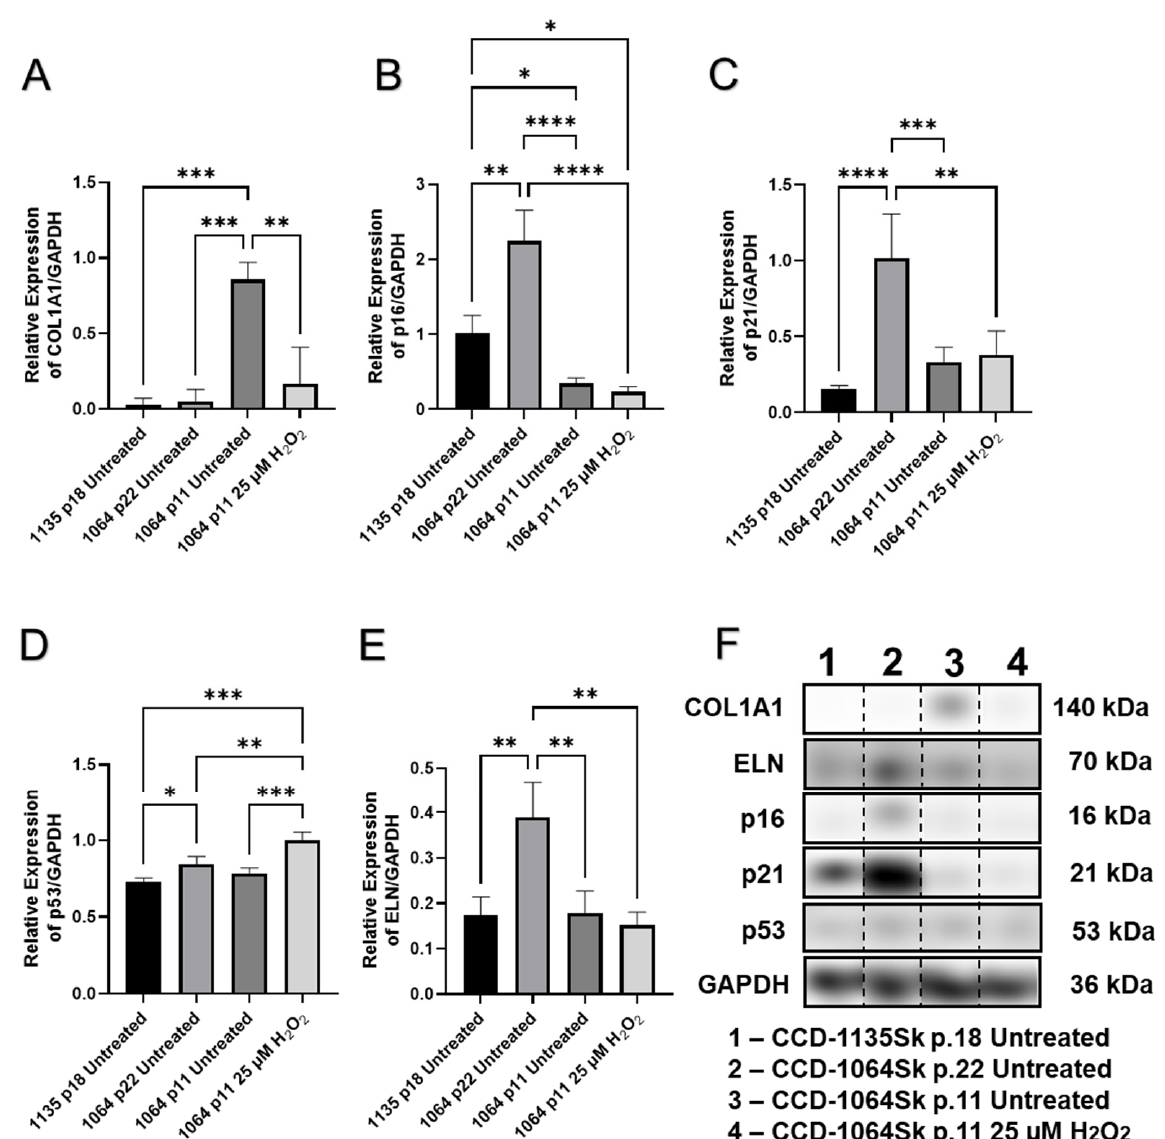
Figure 6. The expression of cellular checkpoint regulators and collagen in aged fibroblasts from different cell lines. Fibroblast’s cell-lines CCD-1135Sk (p.18) and CCD-1064Sk (p.22) aged natu- rally by replicative senescence, and CCD-1064Sk (p.11) was aged by the one-step H 2 O 2